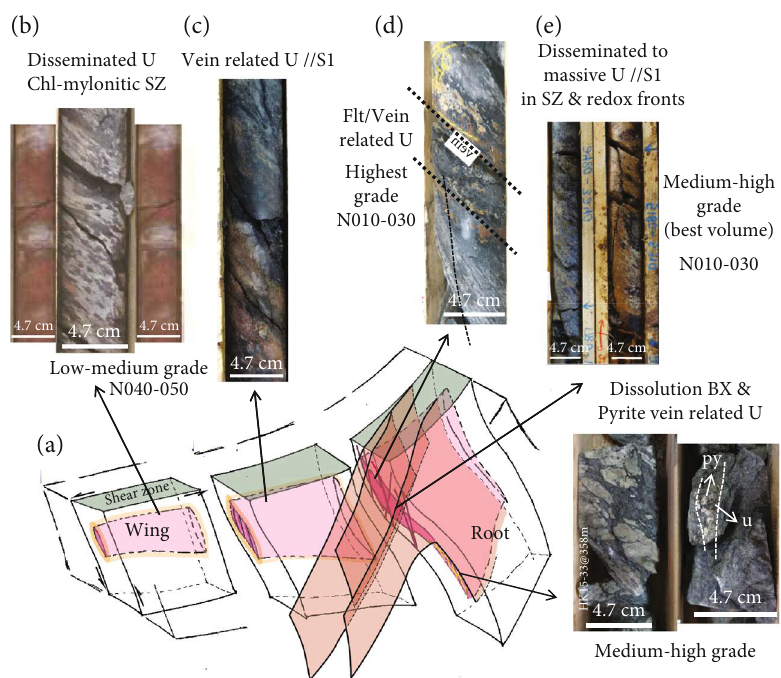
Figure 15: Synthetic 3D sketch of the Spit fi re with a representative sample of mineralized drill core. Chl: chlorite; SZ: shear zone; U//S1: uranium vein parallel to foliation; BX: breccia; Py: pyrite; U: